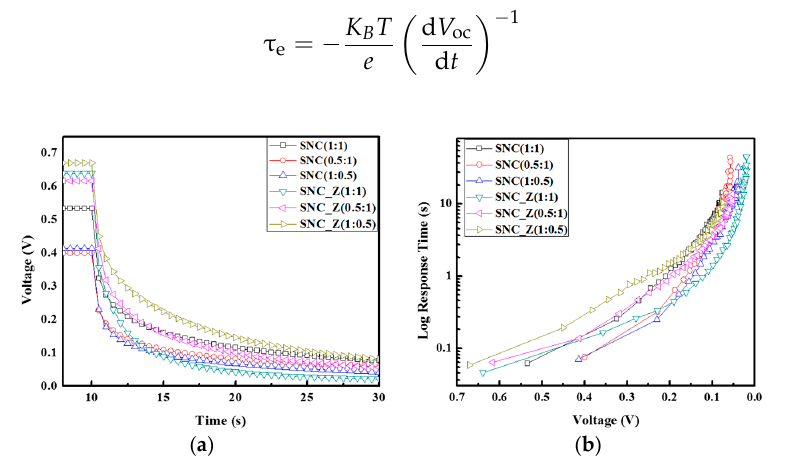
Figure 7. ( a ) Open circuit voltage decay; and ( b ) electron lifetime of the DSSCs based on different Figure photoanodes.